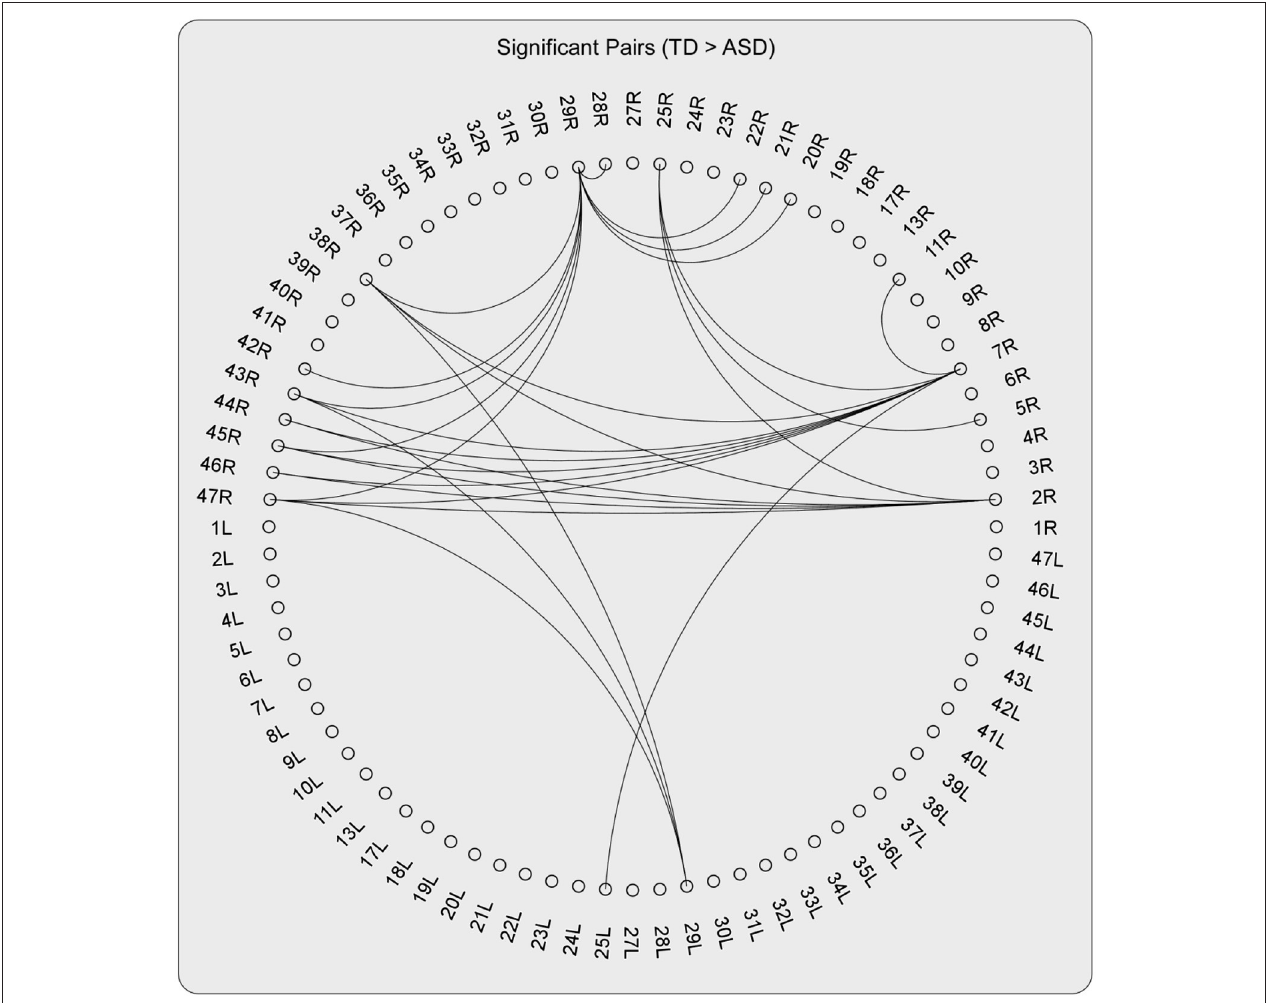
FIGURE 4 | The pairs with significant group effect (TD > ASD) when testing the group differences of the DFA exponents of TV-PS time series in high-gamma